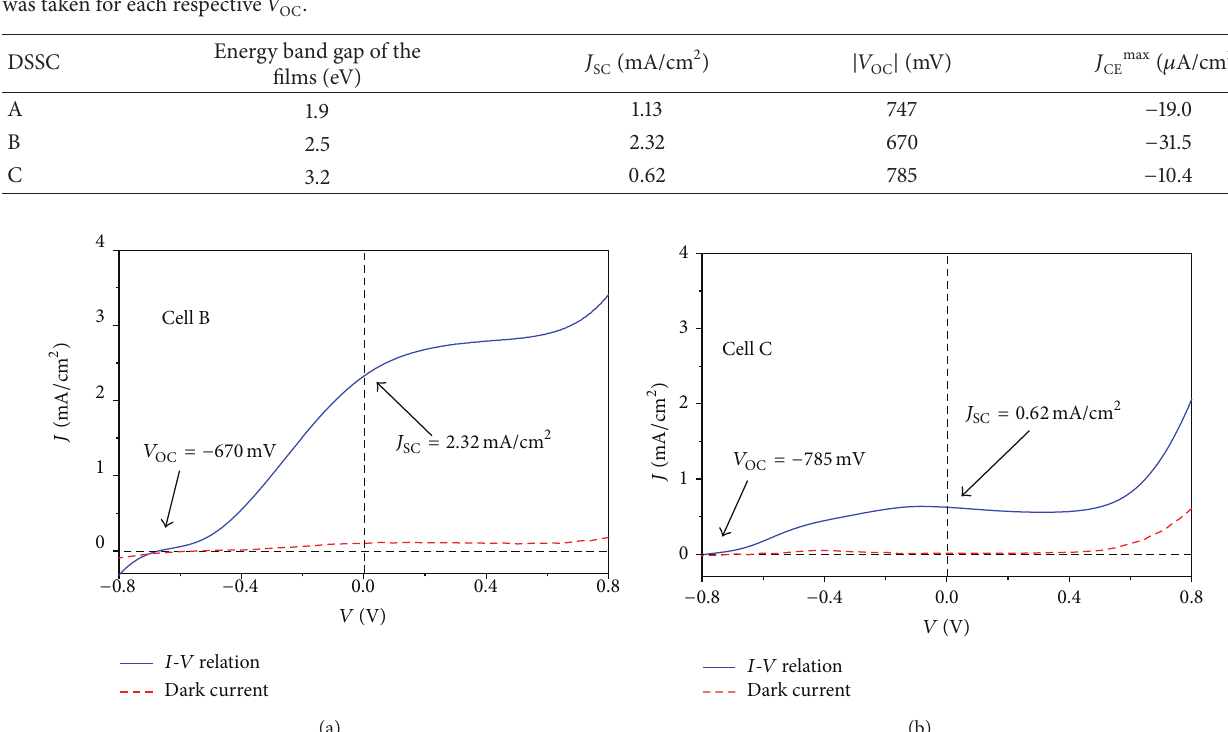
Figure 9: Current-voltage relations for cells B (with nitrogen-doped anatase TiO 2 ) and C (with undoped anatase TiO 2 ) under illuminated and dark